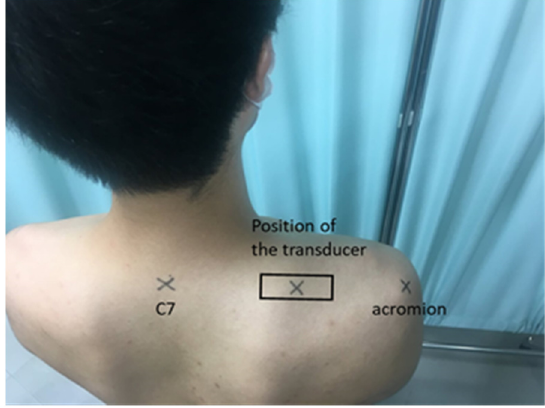
Figure 1. The assessment site of the upper trapezius muscle was defined as the midpoint between the C7 spinous process and acromion.